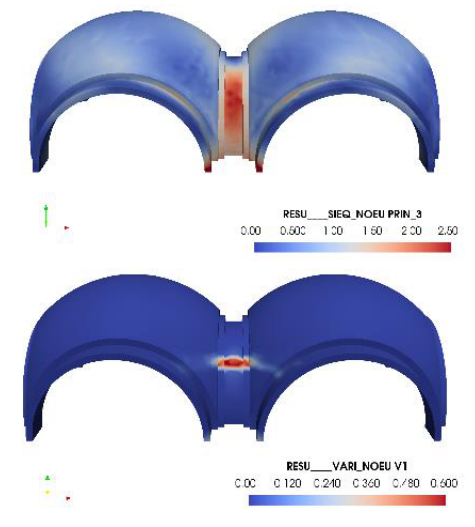
Figure 13. Analysis performed with the vertical displacement imposed on the central column on the 3D idealized geometry model: distribution of maximum principal stresses before cracking (Up) and the damage pattern (Down).